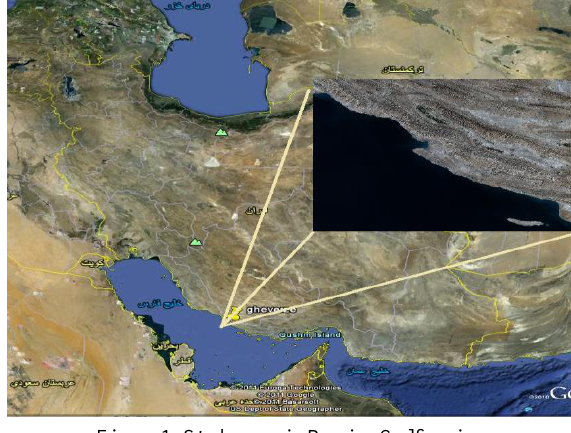
Figure 1. Study area in Persian Gulf region